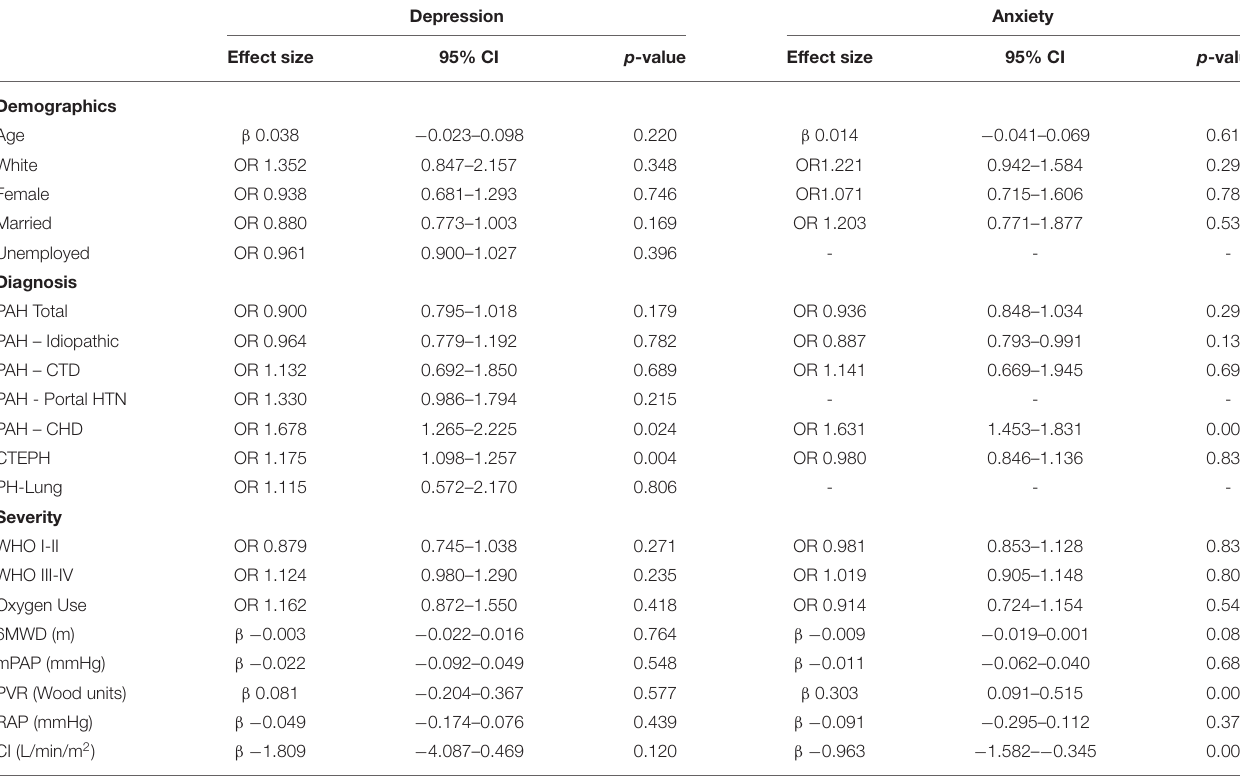
TABLE 3 | Risk factors of depression and anxiety in patients with PH.